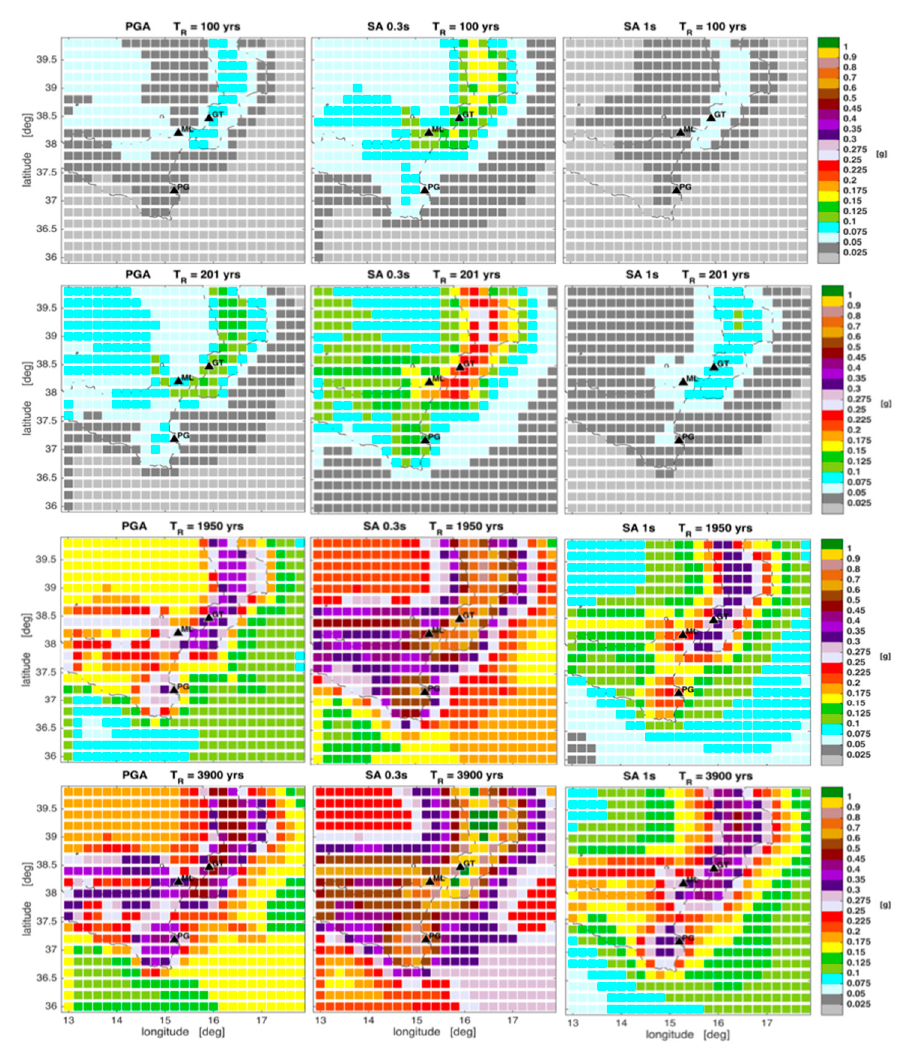
Figure 25. Hazard map computed for the different intensity measures (PGA, and spectral acceleration [SA] at 0.3 and 1 s) and for various return periods (T R ) merging all the branches of the logic tree (see Figure 22).